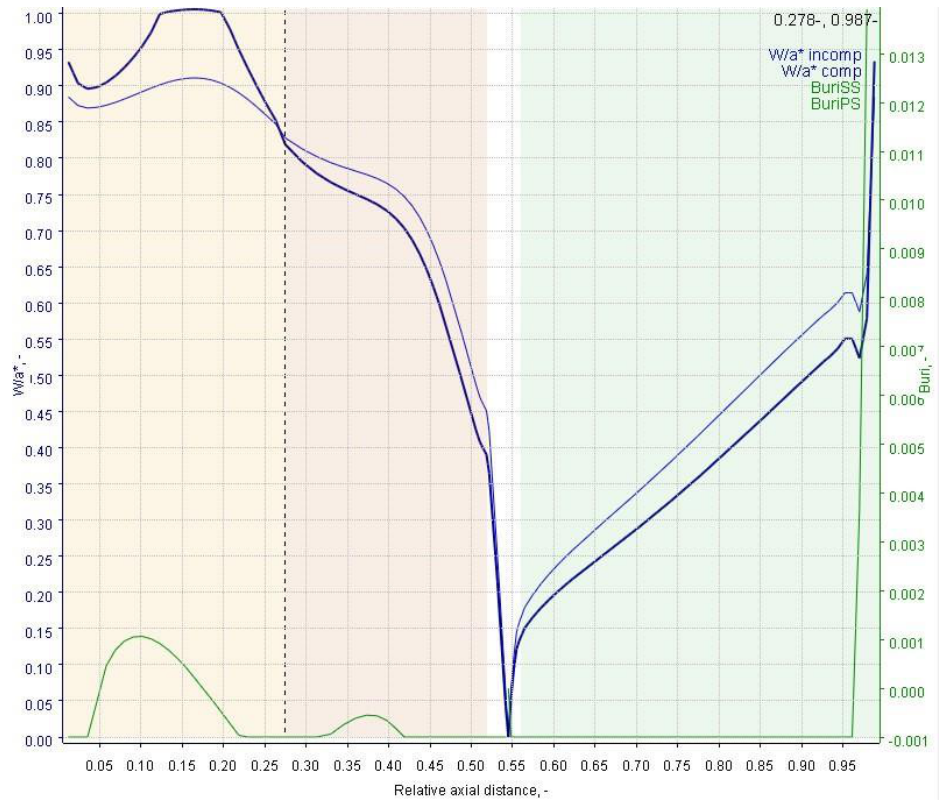
Figure 26. Mach number and Buri criterion plot for the optimized stator airfoil.